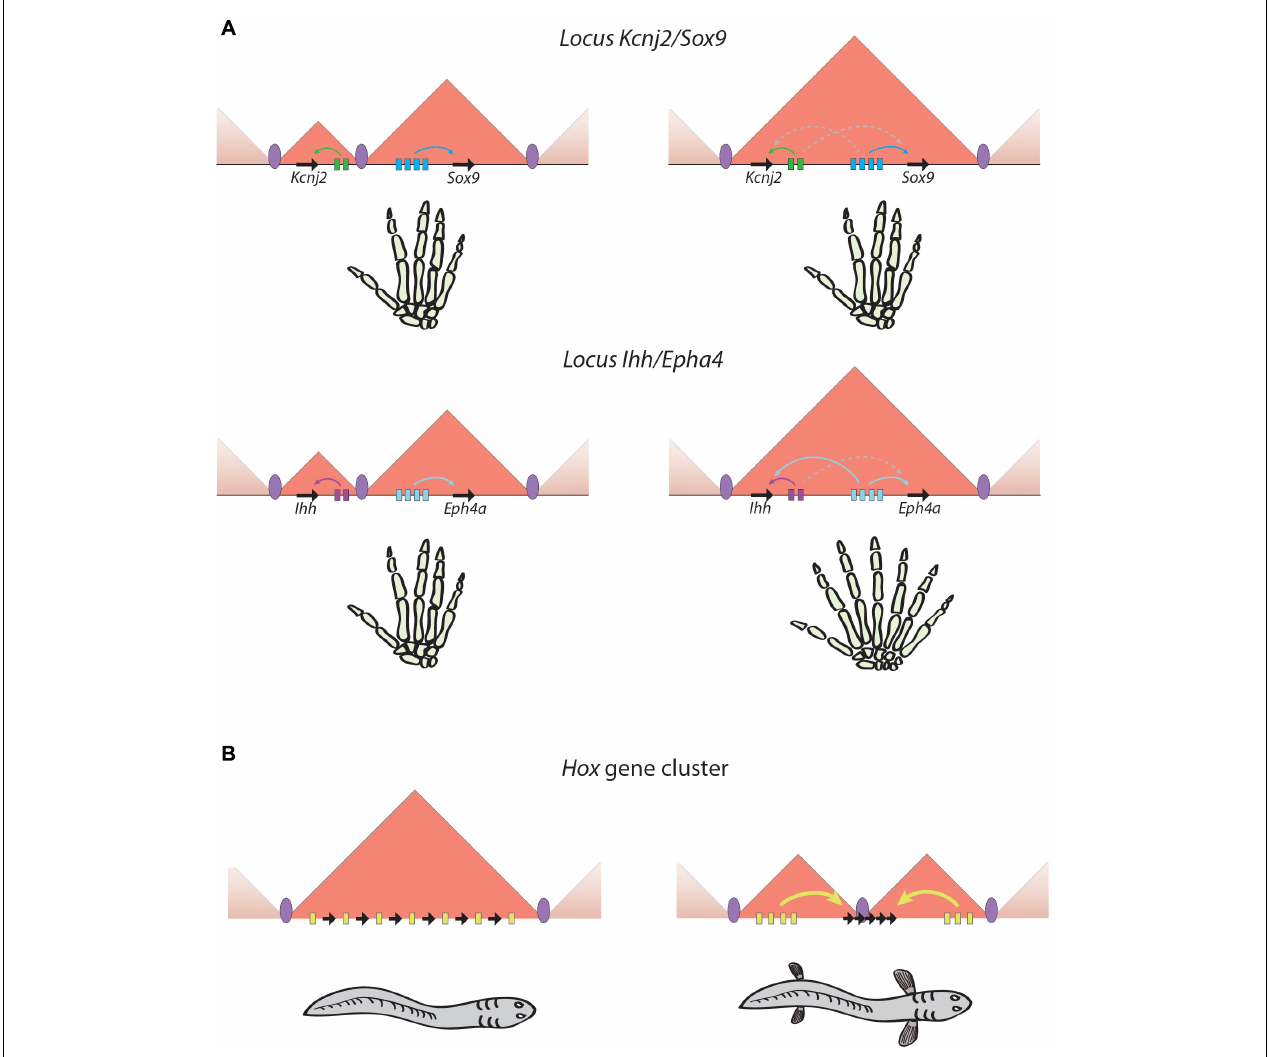
FIGURE 1 | Phenotypical outputs of regulatory landscapes rearrangements. (A) Similar rearrangements may lead to very different situations. In the two examples illustrated in this panel, the fusion of two adjacent TADs produces no detectable phenotype in the case of the Kcnj2/Sox9 locus (Despang et al., 2019), and a striking polydactylia phenotype in the case of the Ihh/Eph4a locus (Lupiáñez et al., 2015). (B) TAD restructuring can generate evolutionary innovations by gaining new regulatory inputs or by increasing regulatory complexity. An example is the splitting of the HoxD and HoxA ancestral TAD found in non-vertebrate chordates in two TADs that are vertebrate-specific and could favor the emergence of vertebrate appendages (Acemel et al., 2016). Black arrows, genes; colored rectangles, enhancers; colored arrows, productive enhancer-promoter interactions; dashed arrows, unproductive enhancer-promoter interactions; purple ellipses, TAD